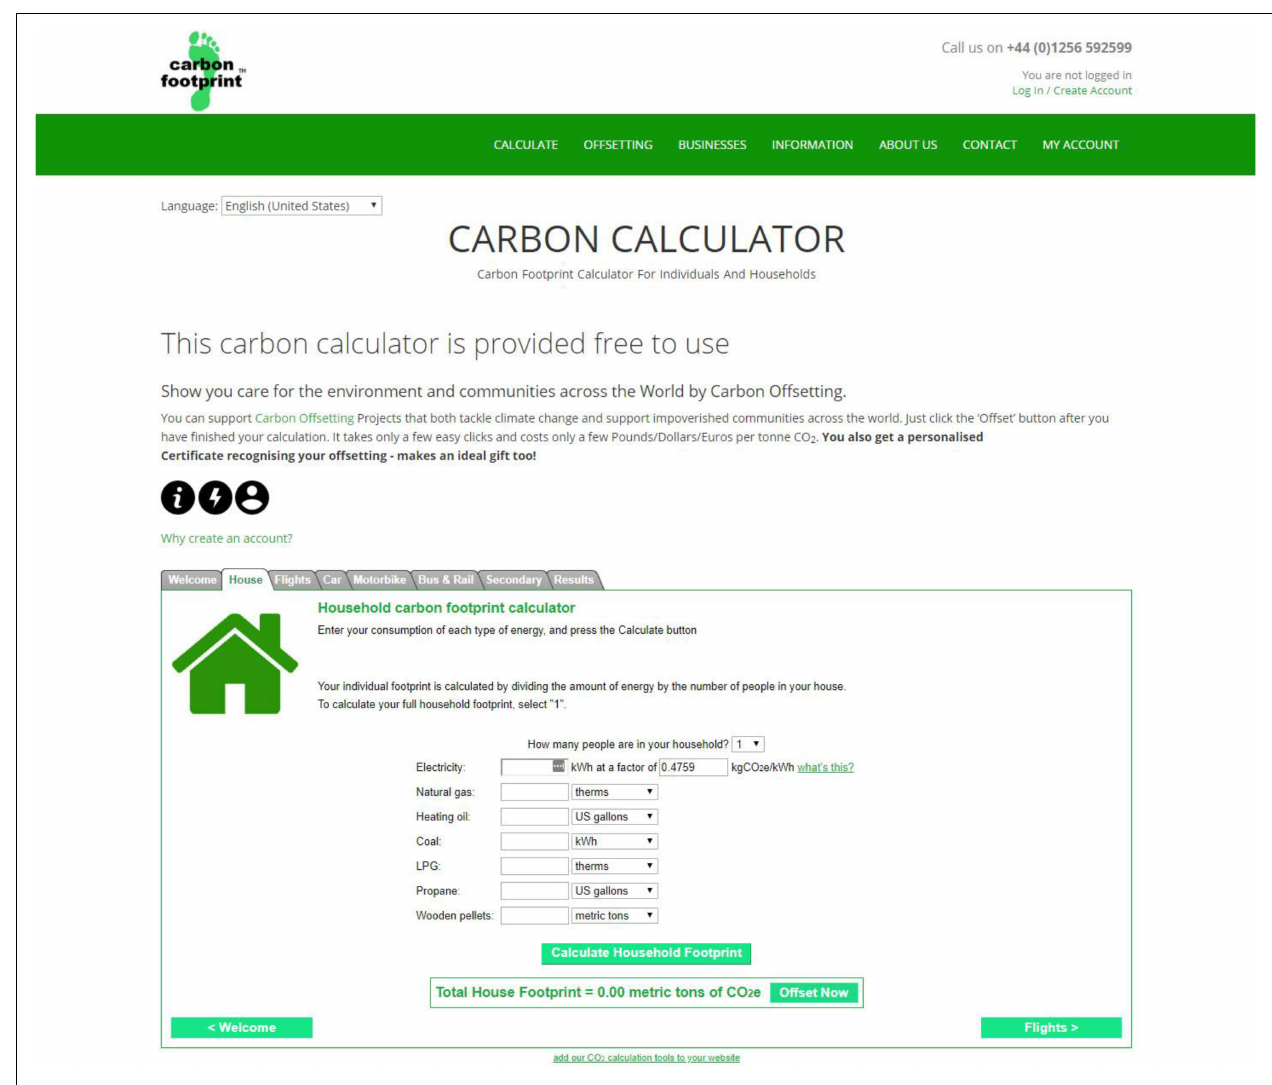
FIGURE 1 | Household carbon footprint calculator data entry